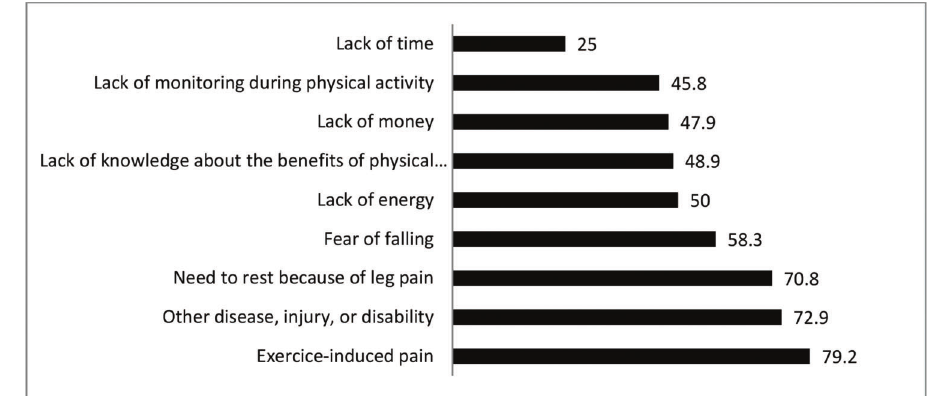
Fig 1 - Prevalence of personal barriers to physical activity among patients with IC.